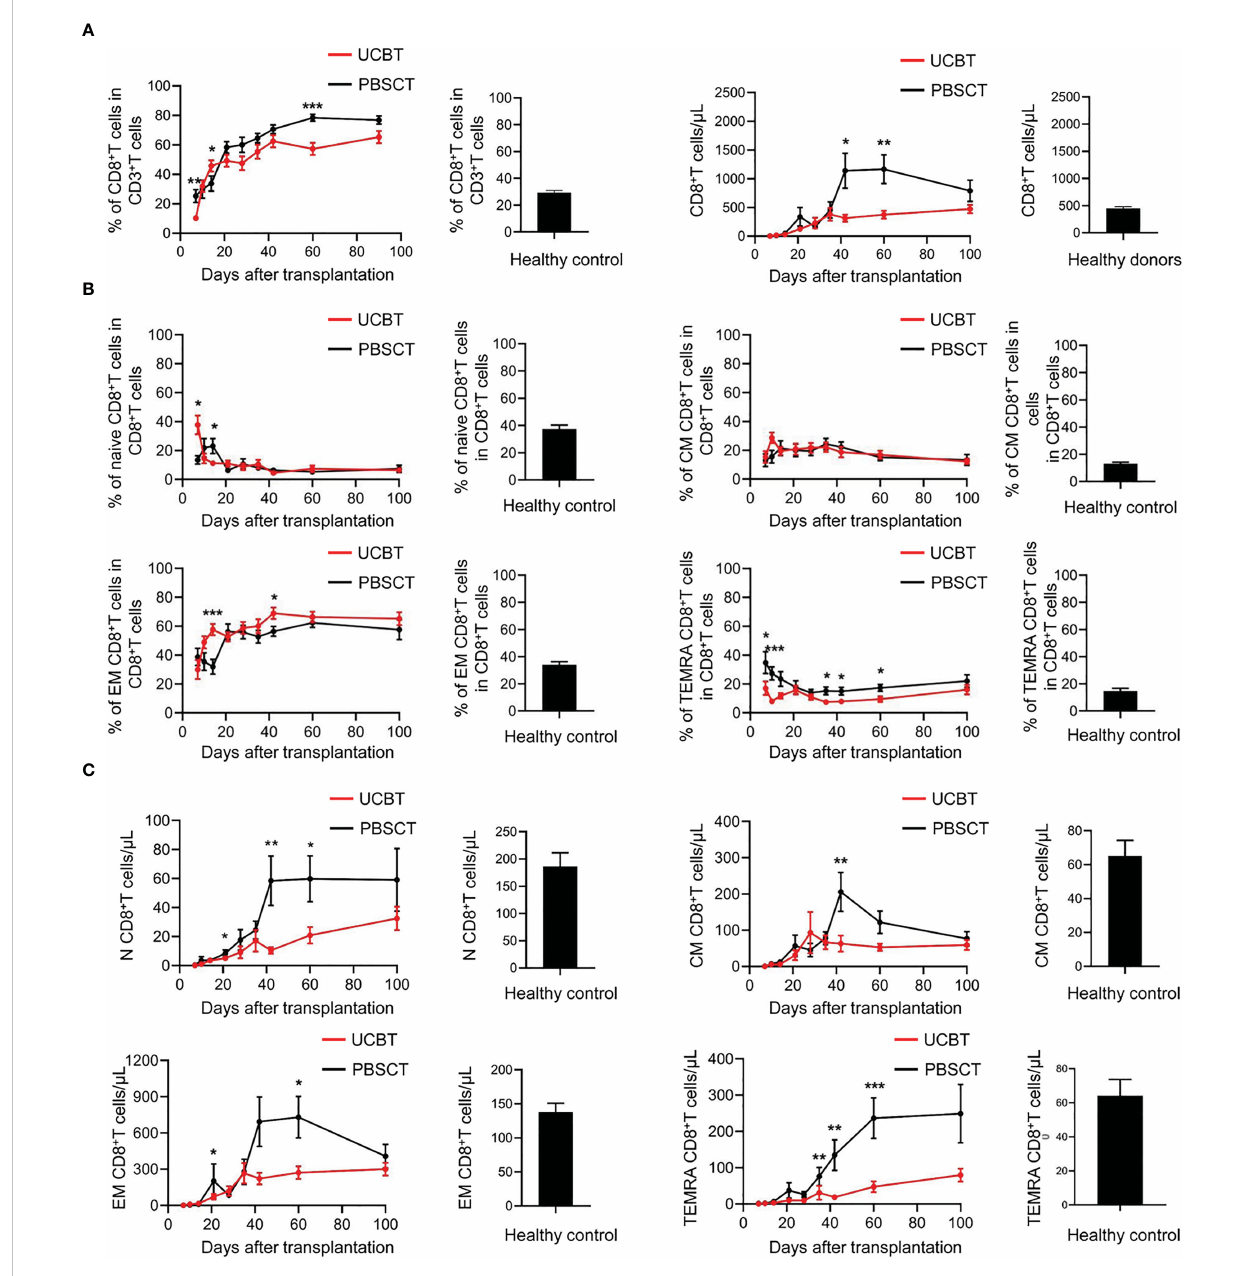
FIGURE 4 The dynamic changes of CD8 + T cell subpopulations in UCBT and PBSCT group patients. (A) The frequencies of CD8 + T cells during the early posttransplant period after UCBT and PBSCT. (B) The frequencies and (C) the numbers of CD8 + T cells subpopulations during the early posttransplant period after UCBT and PBSCT. The data was analyzed by the Mann-Whitney U test and represented as means ± standard error of the mean (SEM). *p < 0.05; **p < 0.01; ***p <